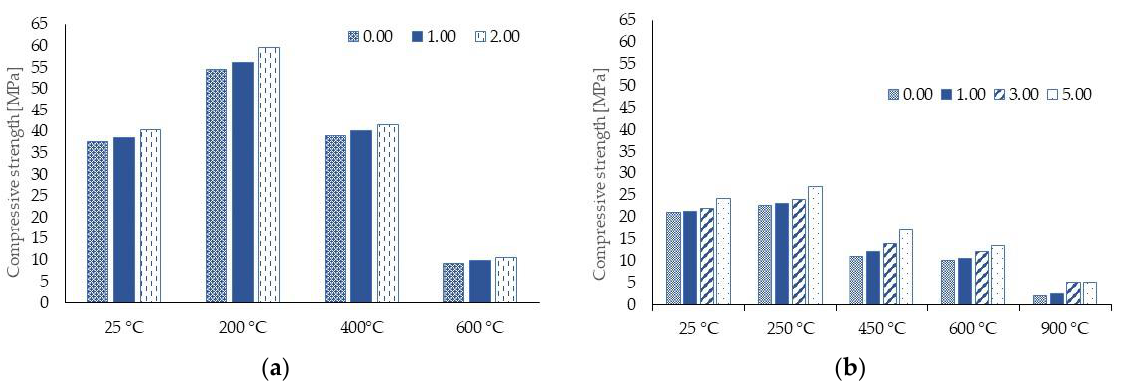
Figure 3. Variation in compressive strength as function of temperature and different percentages of nanoclay. ( a ) results reported in [18]; ( b ) results reported in [28].